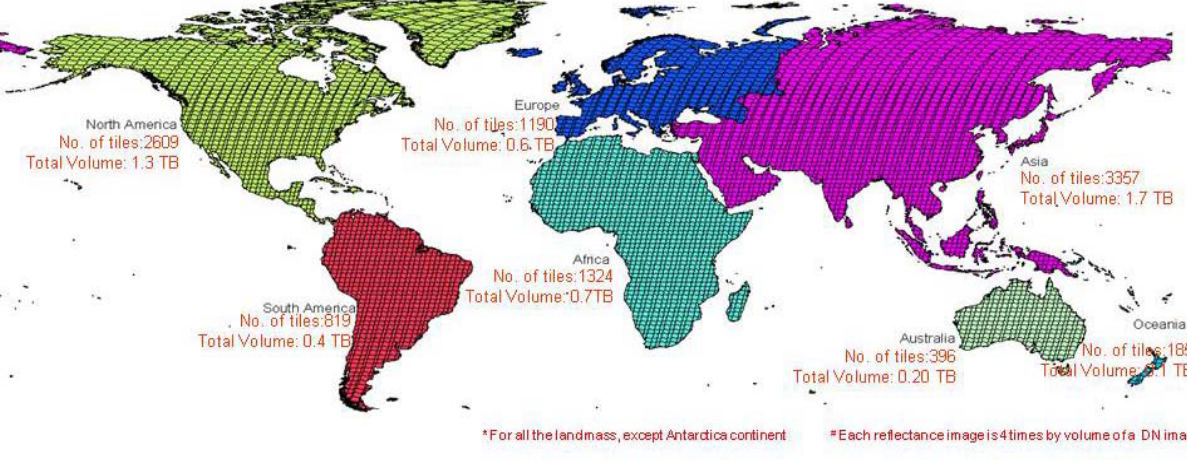
Figure 12. Illustrating the challenges of global mapping at higher spatial resolution. Distribution of Landsat 30 m images for the world. About 9,500 images are required to cover the terrestrial world, with a total data volume of about 20 TB. With advanced compression techniques this can be reduced to about 4 TB. Yet, single shot Landsat images need to be fused with time-series imagery such as MODIS 250 m or 500 m for a realistic analysis of croplands or other land use. This further adds to data volume. Further, processing such high volume data brings its own challenges. This will require us to use super computer facilities. Image Credit: Mr. Manohar Velpuri, South Dakota State University, South Dakota,